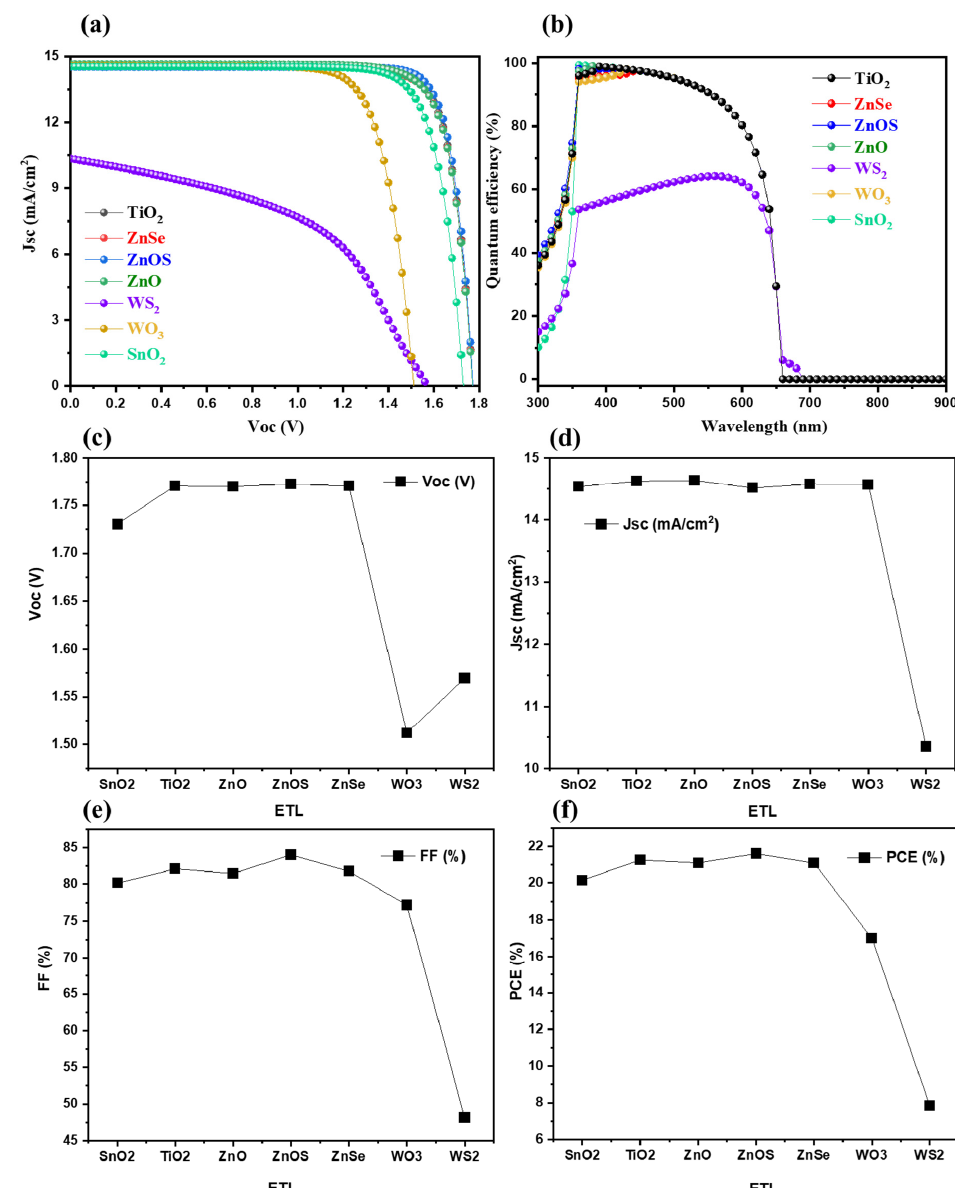
Figure 4. J-V curves ( a ) and EQE curves ( b ) of the simulated PSCs (FTO(500 nm)/different ETL(100 nm)/MAGeI 3 (550 nm)/spiro-OMeTAD(100 nm)) at 300 K. Extracted Voc ( c ), Jsc ( d ), FF ( e ) and PCE ( f ) of the simulated PSCs (FTO(500 nm)/different ETL(100 nm)/MAGeI 3 (550 nm)/spiro- OMeTAD(100 nm)) at 300 K.